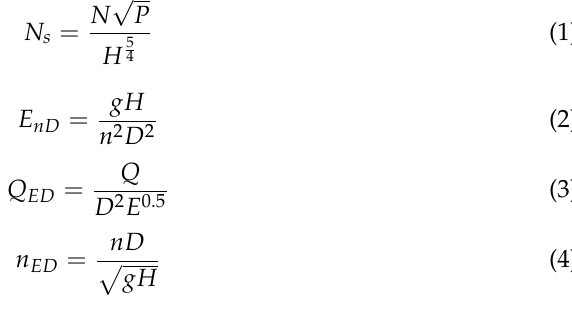
Table 1. Specifications of the Francis turbine model.